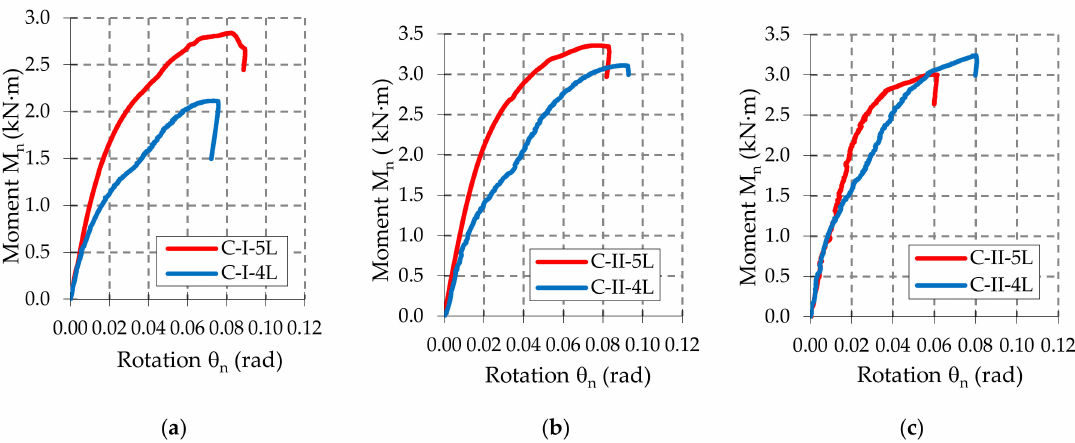
Figure 11. Comparison of the moment-rotation curves recorded for: ( a ) C-I-4L and C-I-5L assemblies, ( b ) C-II-4L and C-II-5L assemblies, and ( c ) C-III-4L and C-III-5L assemblies.